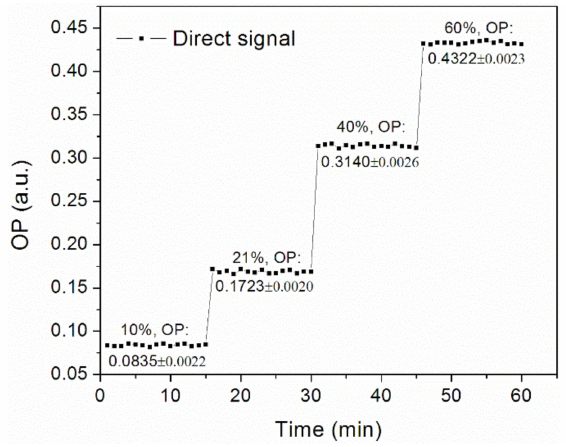
Figure A1. Fluctuations of the measured results under different oxygen